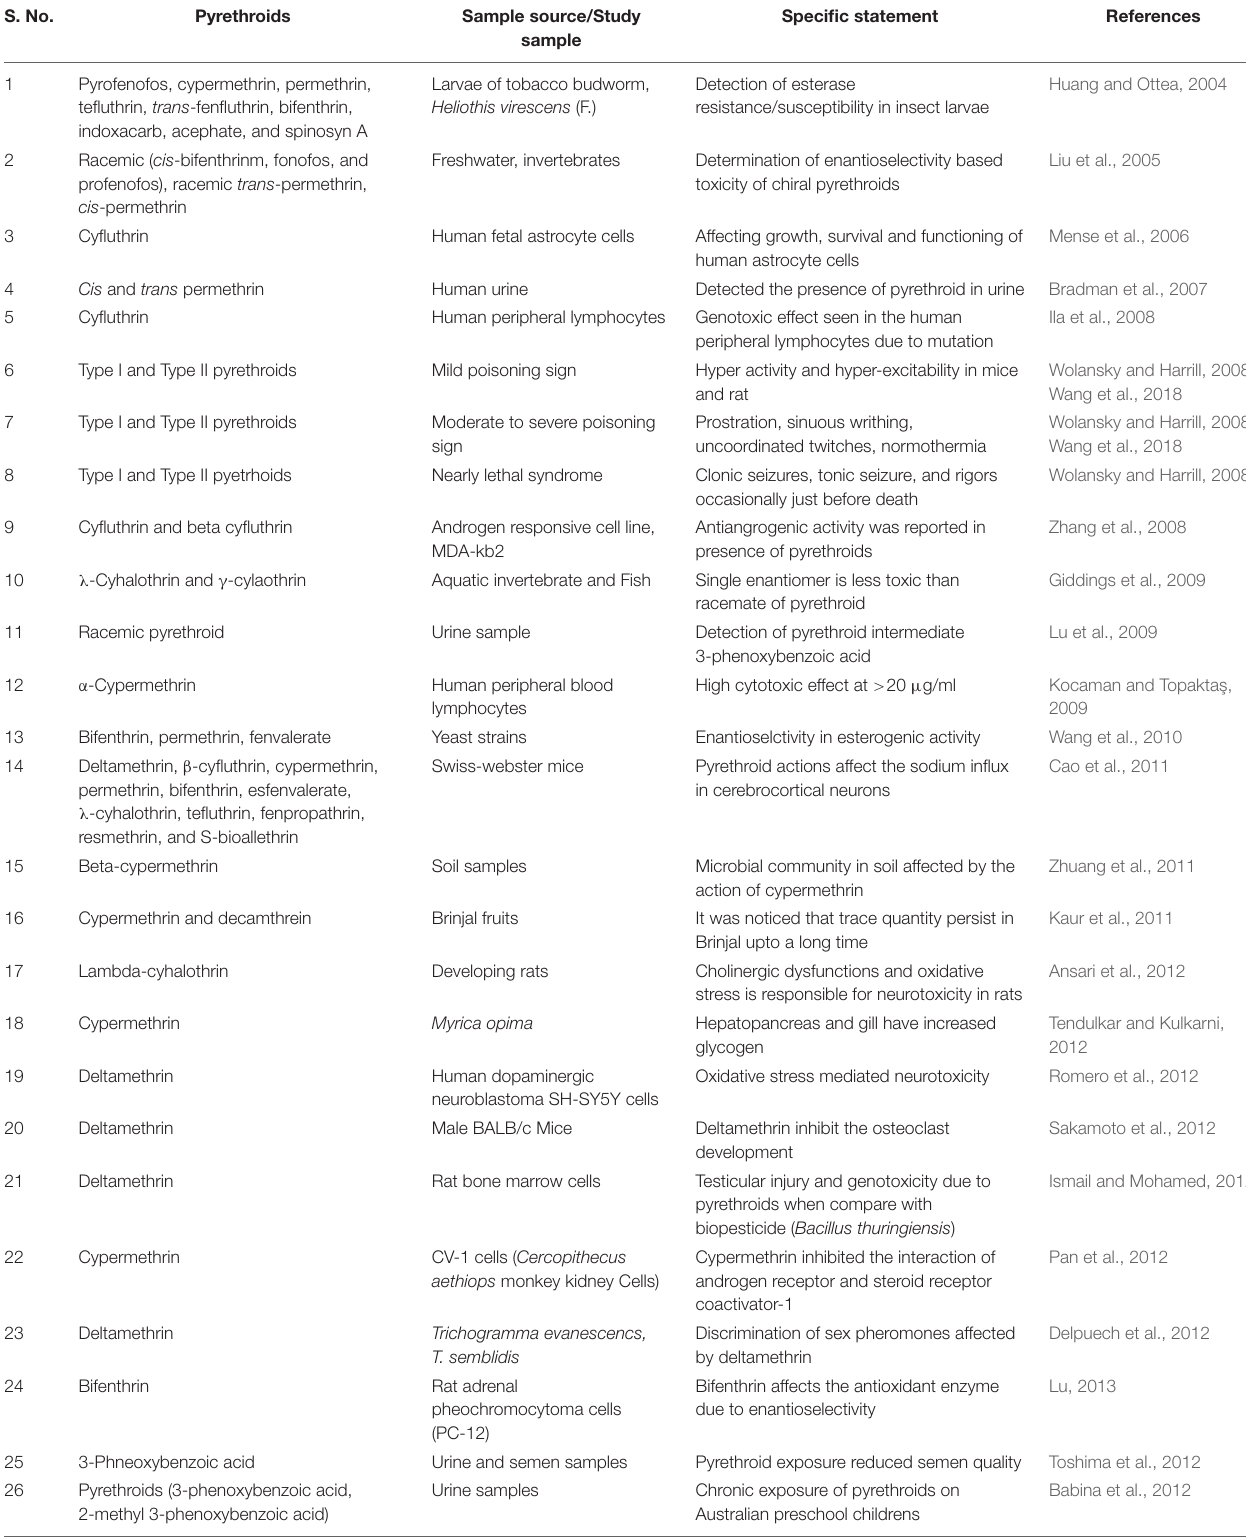
TABLE 2 | Hazardous effects of different